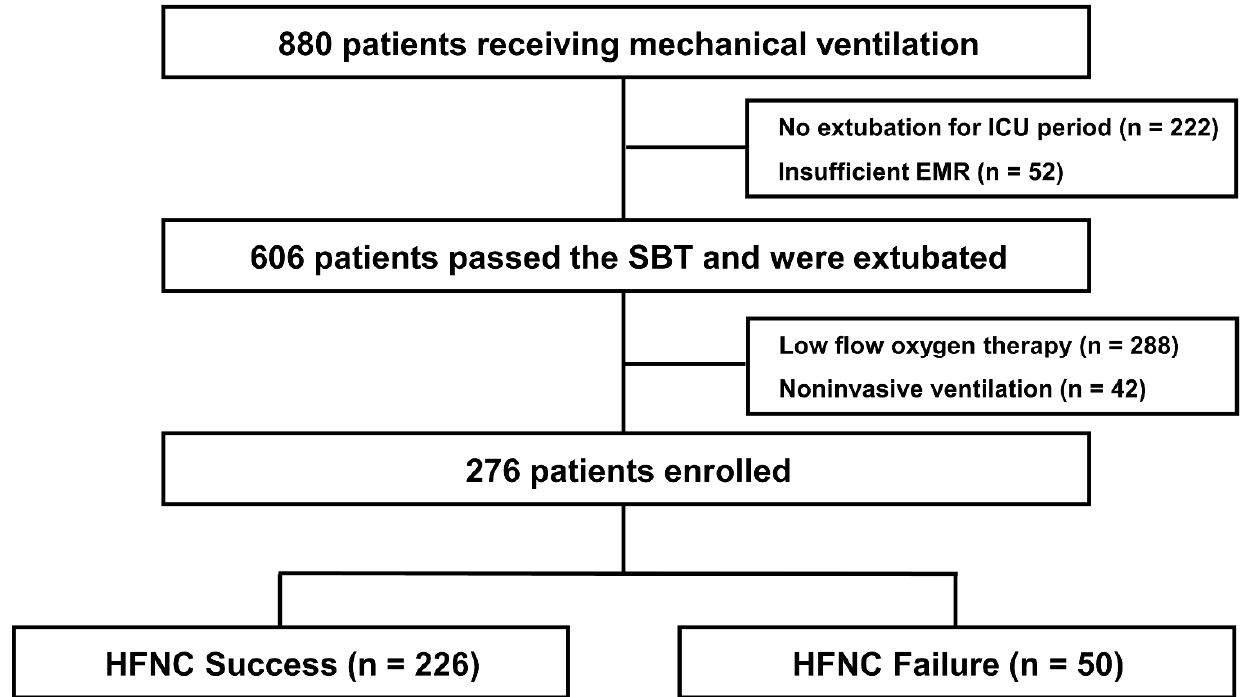
Figure 1. Flow chart of enrolled patients. ICU, intensive care unit; EMR, electric medical records; SBT, spontaneous breathing trial; HFNC, high-flow nasal cannula.